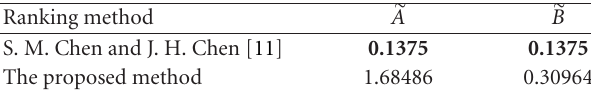
Table 1: Comparison results of Figure 2.